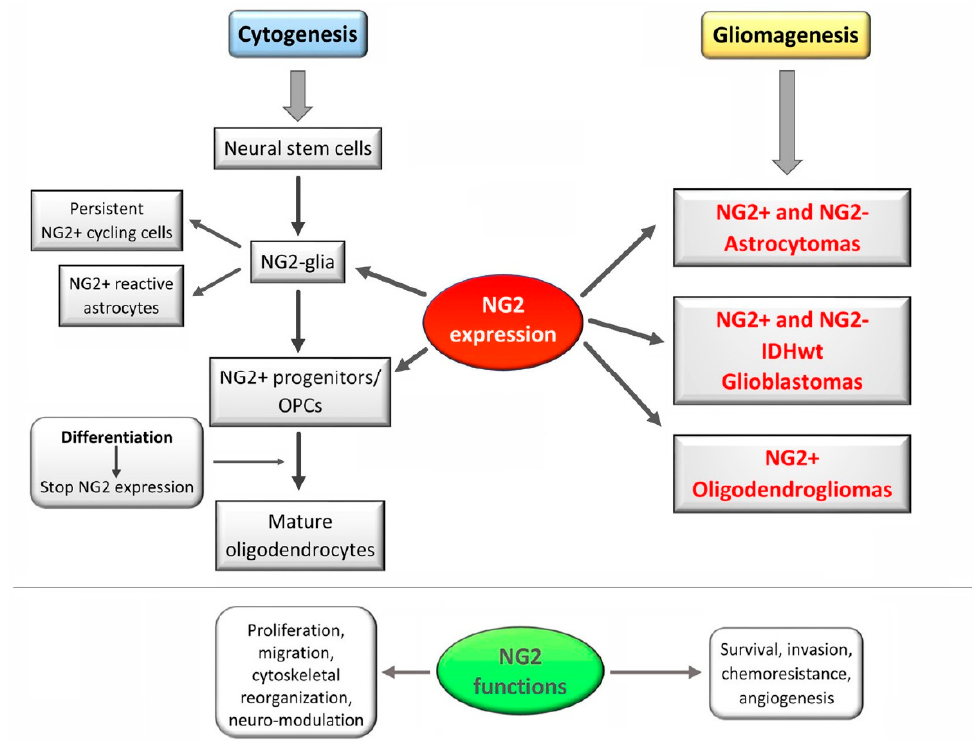
Figure 1. Summary scheme of NG2/CSPG4 expression during neurogenesis and gliomagenesis, and its functions in normal and pathogenetic mechanisms of the central nervous system (CNS). Expression of NG2/CSPG4 is found in subsets of normal glial cells in developing and adult CNS. It is not expressed by multipotent stem cells but is upregulated in the NG2-glia and in the partially-committed oligodendrocyte precursor cells (OPCs) that are still proliferative and motile. Upon terminal differentiation of these progenitors in mature oligodendrocytes, NG2/CSPG4 is downregulated. It is once again upregulated in pathological conditions, including malignant cancers. NG2/CSPG4 aberrant expression has been associated with gliomas where it affects cancer cell adhesion, migration, proliferation, resistance, and angiogenesis.